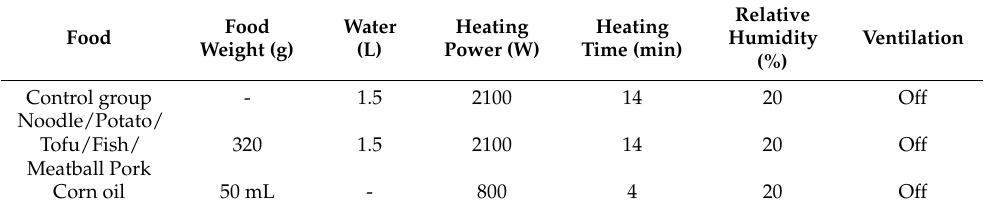
Table 1. The experimental